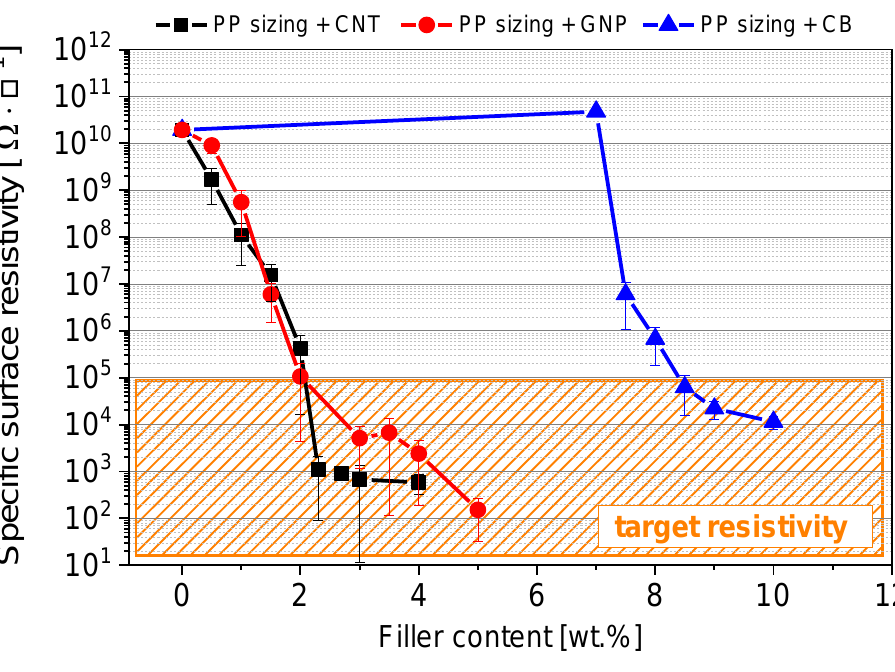
Figure 7. Electrical percolation behavior of different used carbon filler in polypropylene (PP), measured on consolidated drop-casted films on glass sheets.